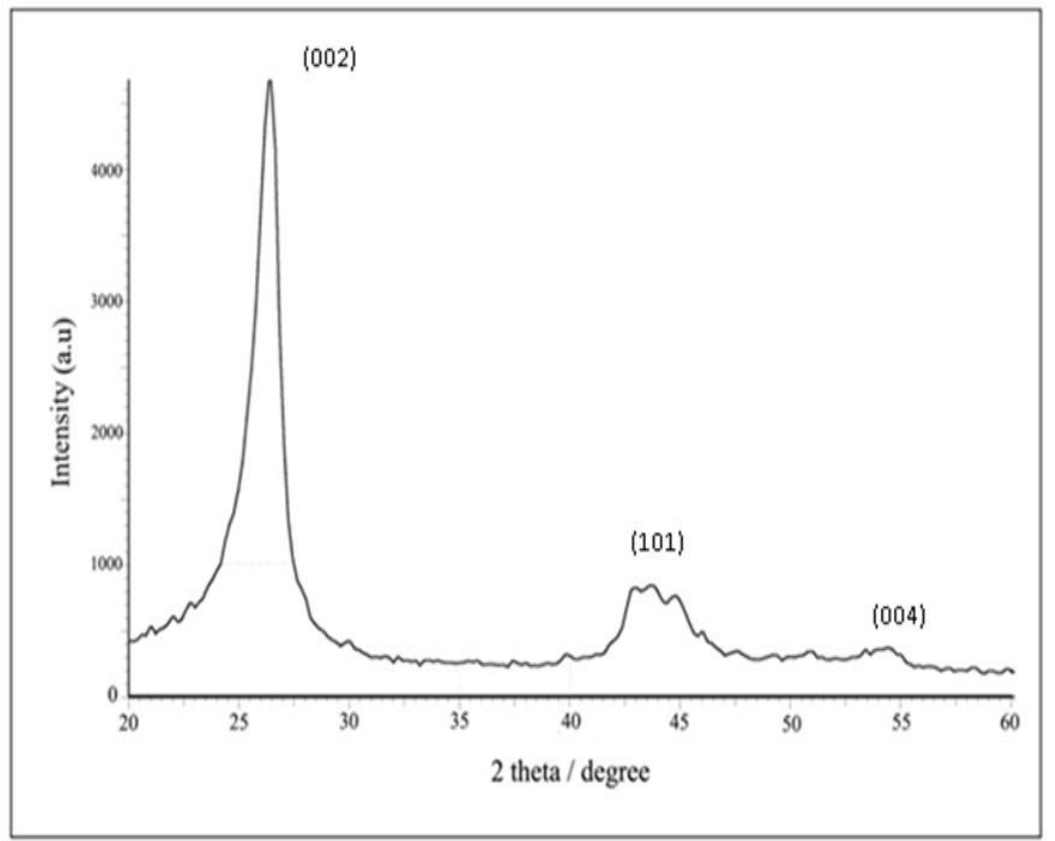
Fig. 4: XRD the spectroscopy of graphite nano-powders obtained by